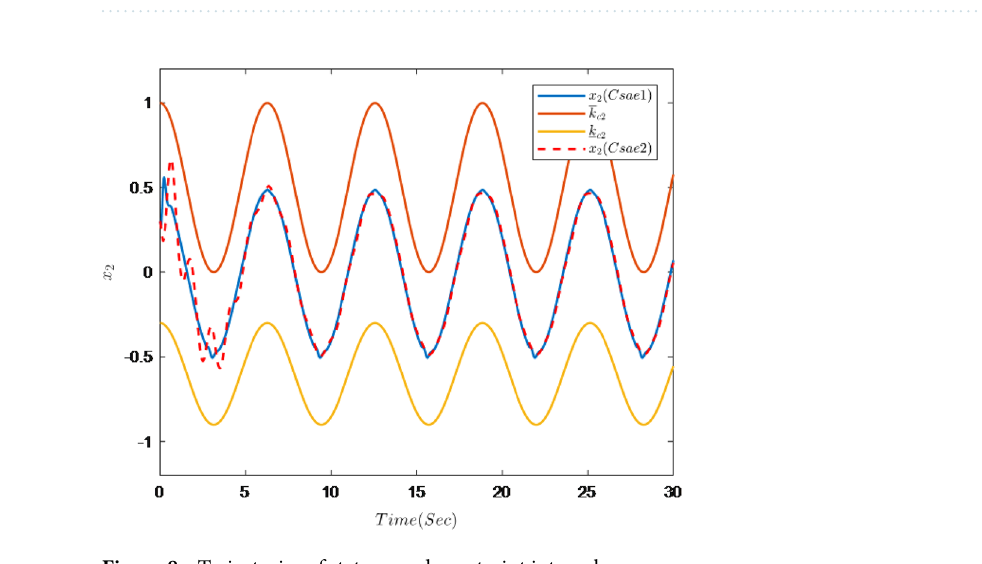
Figure 8. Trajectories of state x 2 and constraint interval.